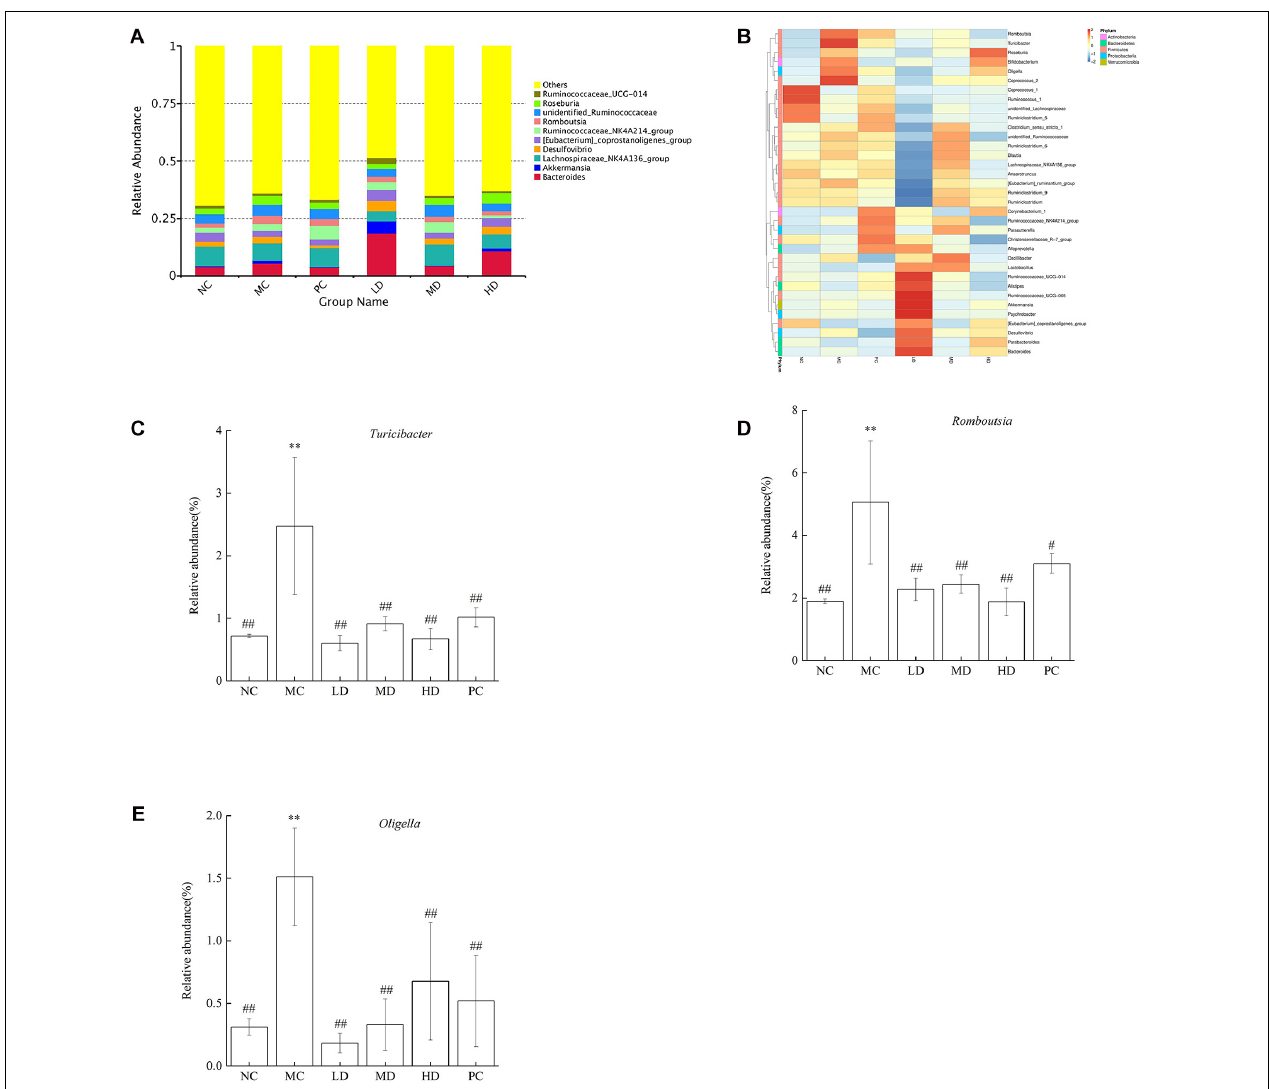
FIGURE 3 | Relative abundance of gut microbiota at the genus level. (A) Bacterial taxonomic profiling at the genus level of gut microbiota. (B) Heatmap analysis at the genus level among different test groups displayed the changes in the relative abundance of identified genus. (C) Turicibacter , (D) Romboutsia , and (E) Oligella . Differences were based on ANOVA analysis followed by LSD post hoc test and denoted in graph bars as follows: ∗ p < 0.05 and ∗∗ p < 0.01 compared with NC; # p < 0.05 and ## p < 0.01 compared with MC.